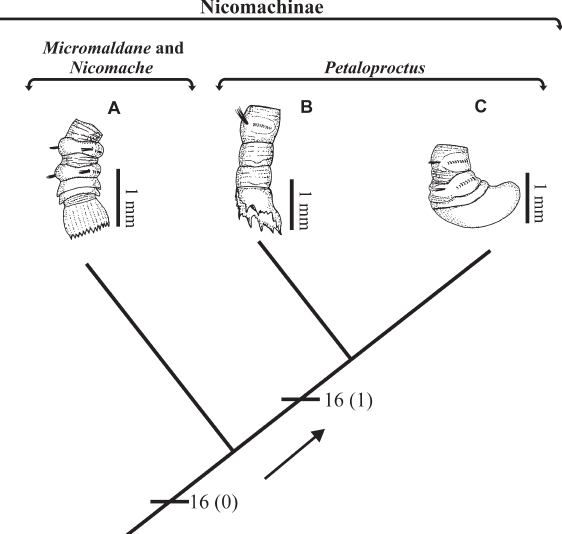
Fig . 1. – Phylogenetic hypothesis for the reduction of the dorsal bor- der of the pygidium in Petaloproctus . A, Nicomache (Nicomache) lanai , posterior end in dorsal view; b, Petaloproctus sp, posterior end in lateral view; C, Petaloproctus vallejoi n. sp., posterior end in lateral